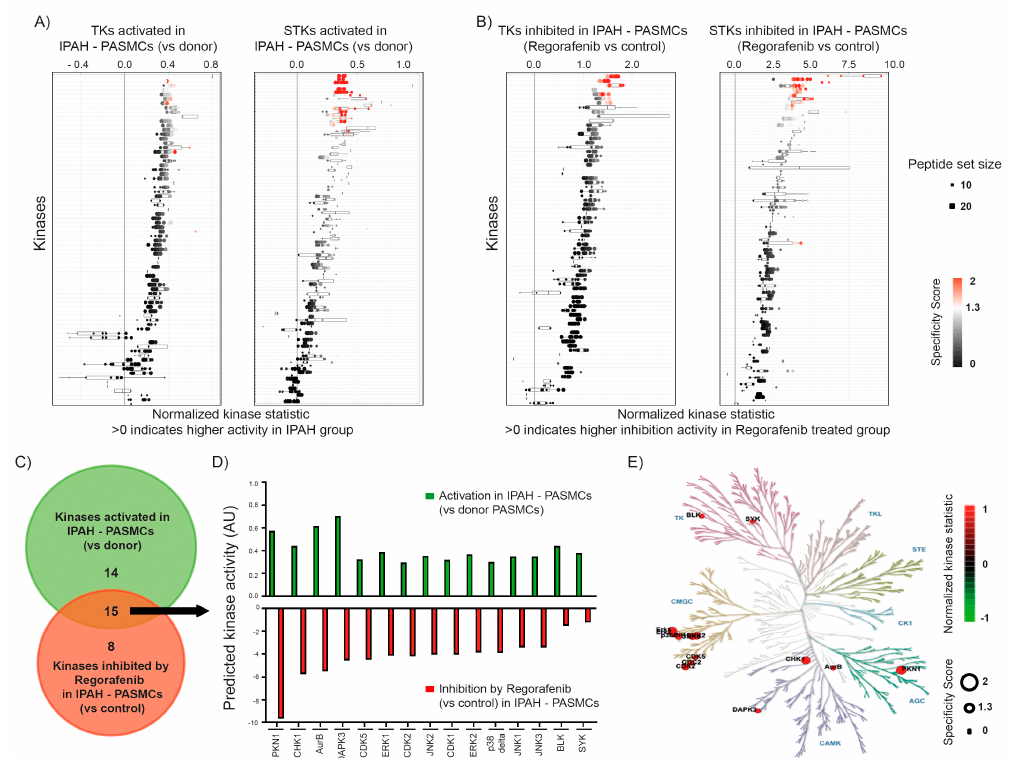
Figure 1. Effect of regorafenib on tyrosine kinases (TKs) and serine/threonine kinases (STKs) in idiopathic pulmonary arterial hypertension smooth muscle cells. Kinome analysis of tyrosine kinases (TKs) and serine/threonine (STKs) kinases carried out by peptide array-based kinase activity assay in donor and idiopathic pulmonary arterial hypertension (IPAH)-pulmonary arterial smooth muscle cells (PASMCs) ( n = 3, biological replicates). Normalized statistic kinases representing predicted kinase activity of TKs and STKs ( A ) (>0) in IPAH versus donor PASMCs and ( B ) expected inhibition (>0) by regorafenib treatment against DMSO control in IPAH-PASMCs. Y -axis shows the list of kinases while the size of dots indicates the respective peptide set size (10 to 20). The number of dots for each kinase is an outcome of an individual permutation analysis of peptides with varying rank-cut off values. Specificity score (0–2) indicates statistical relevance, >1.3 (negative log10 ( p -value) with p = 0.05) is statistically significant. ( C ) Venn diagram represents differentially